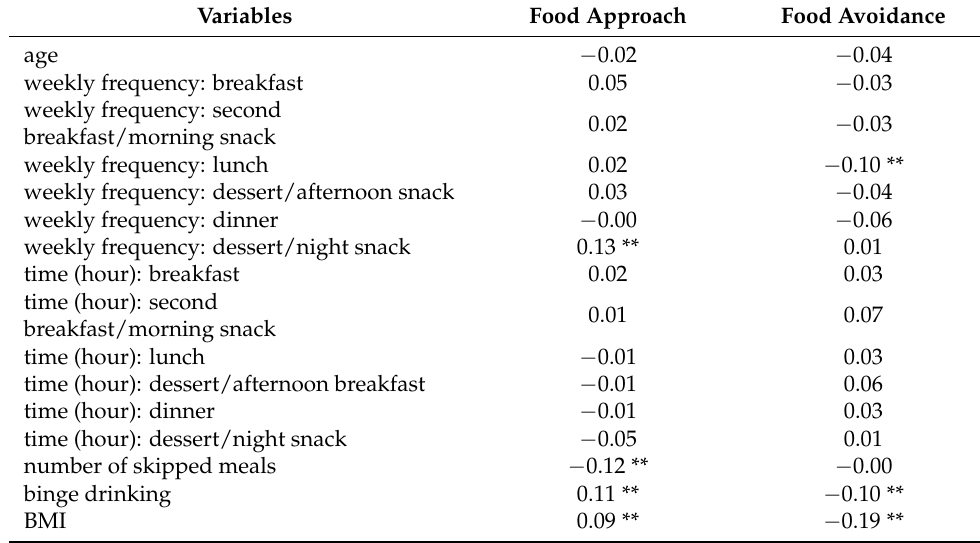
Table 9. Relationships between variables—Kendall’s tau-b correlation coefficients (N = 531). Variables Food Approach